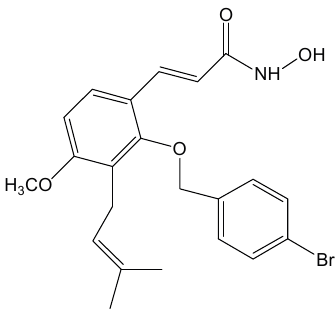
Figure 1. Structure of NBM-T-BBX-OS01